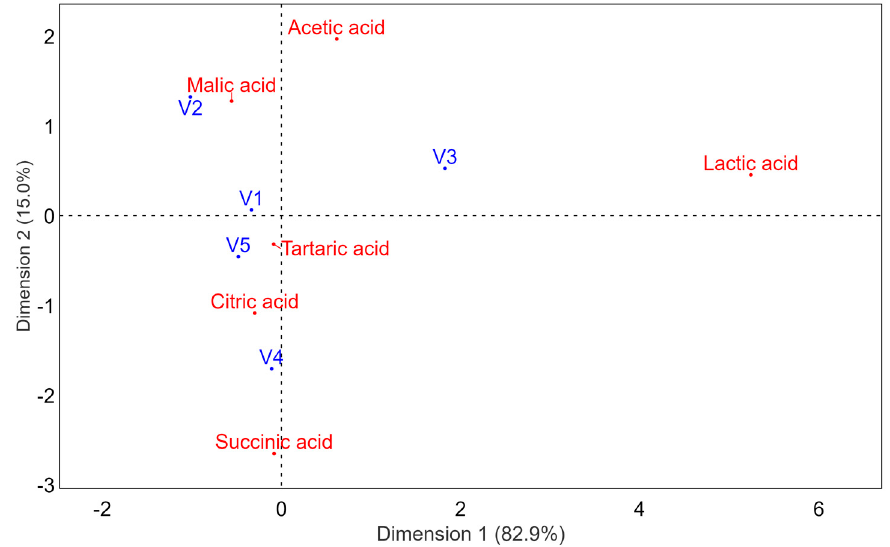
Figure 2. Correspondence analysis of wine’s organic acids profile.